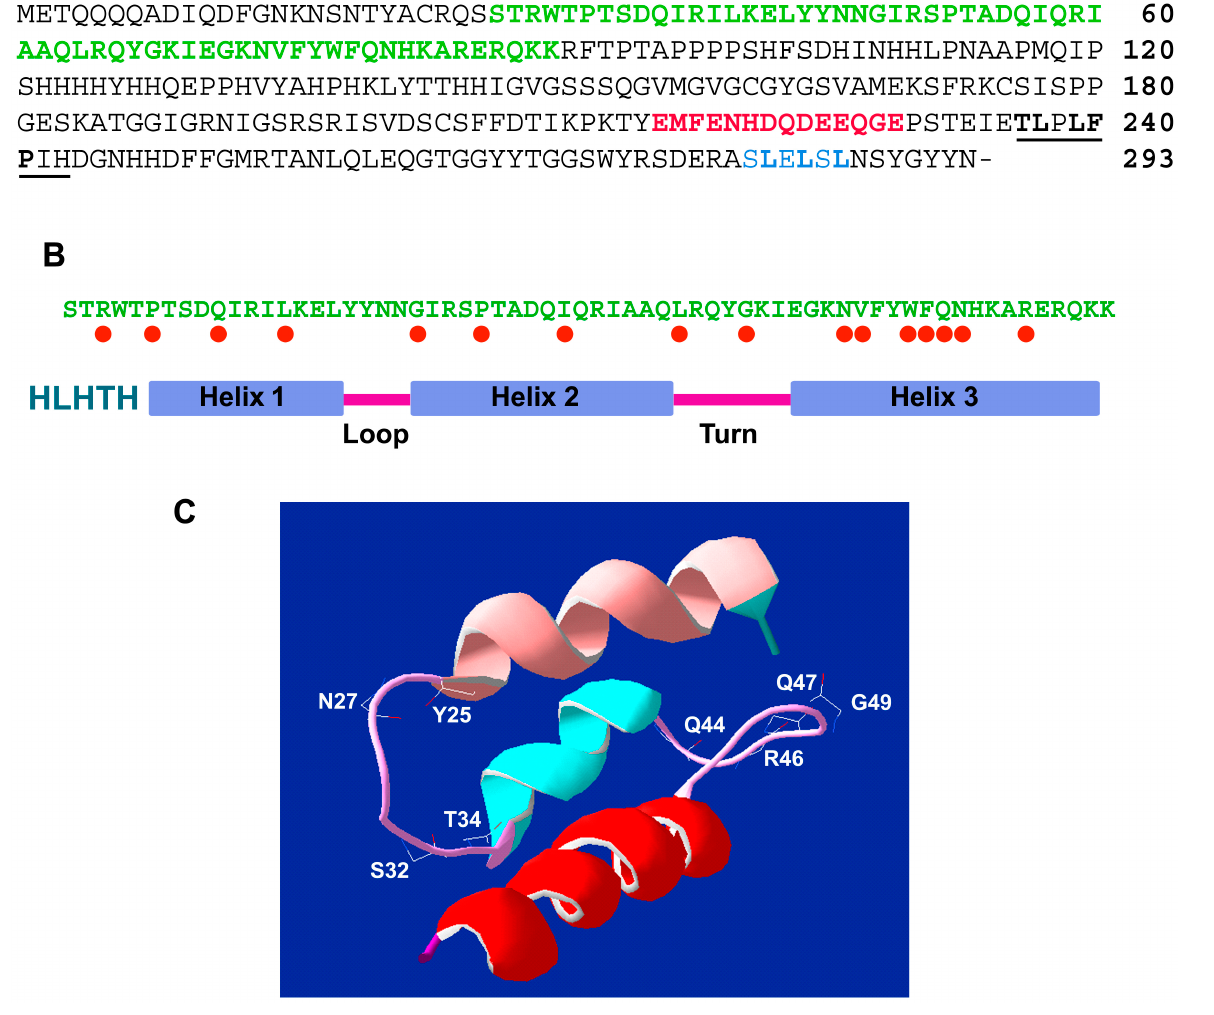
Figure 2. Analysis of WUSCHEL transcription factor from sunflower (HaWUS) (GenBank accession HE616565.1). ( A ). Amino acid sequence of HaWUS (293 amino acid residues). The homeodomain is in bold and green characters; the WUS-box motif ( TL P LFP XX) is underlined, and the con- served amino acid residues are in bold character. The EAR-like motif is in light blue character, the conserved amino acid residues are in bold character, and the acidic region is in red character [84].